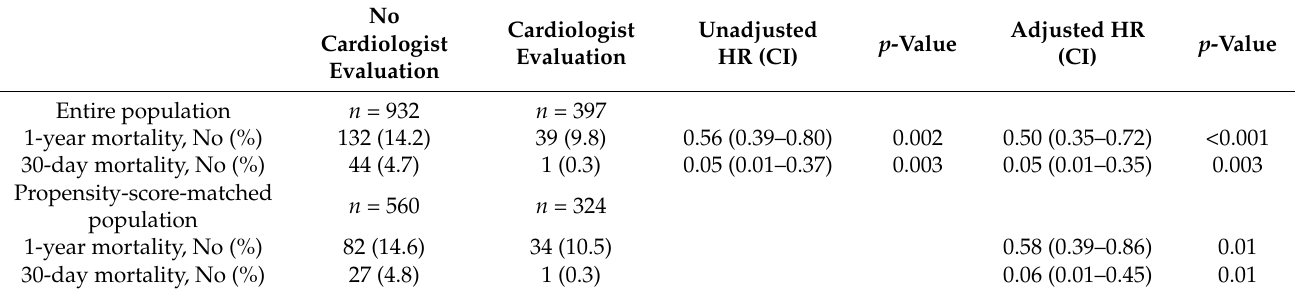
Table 2. Mortalities according to measurement of troponin at